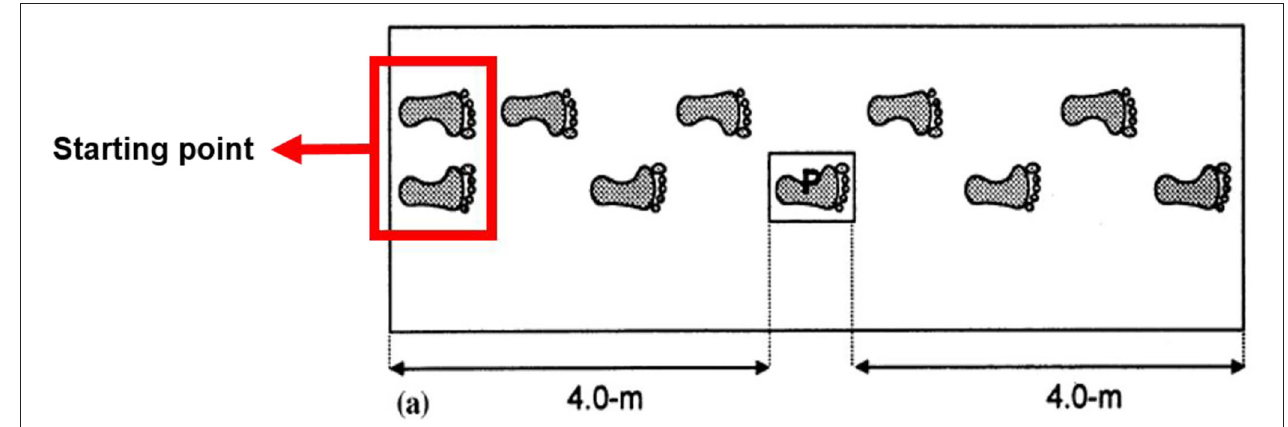
FIGURE 1 | Midgait method. Participants start 4.0m from the platform (P) [Adapted from Wearing et al.